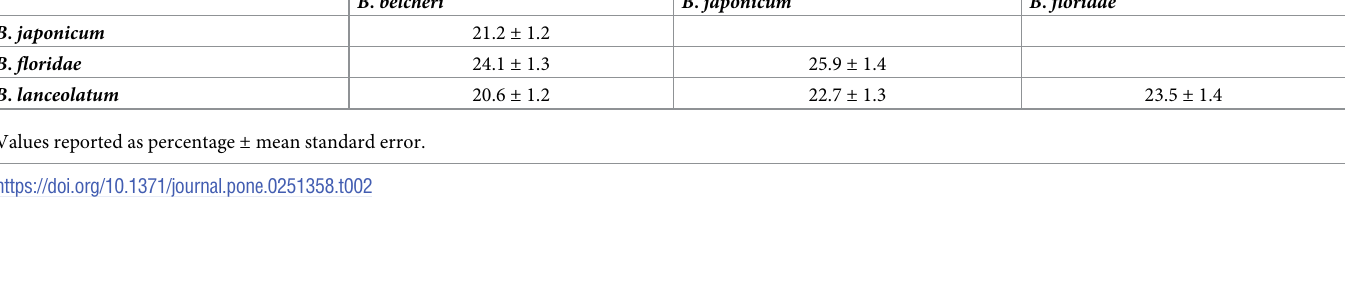
Table 2. Average of the uncorrected pairwise genetic distances between Branchiostoma species based on the concatenated dataset (COX1, 12S, and 16S).